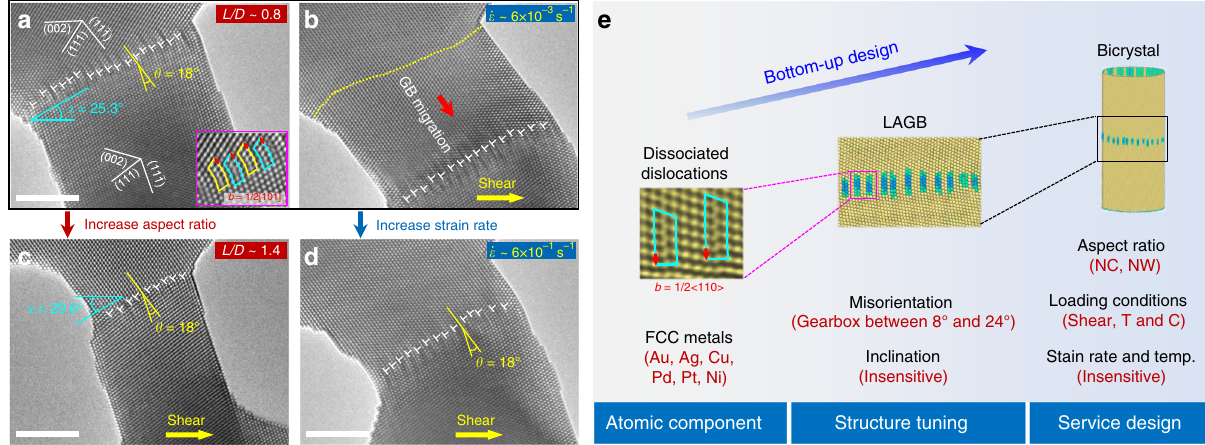
Fig. 4 Bottom-up design of plastic reversibility in Au bicrystals with dislocation-type GB. a Au bicrystal consisting of an 18° 1 (cid:1) 10 ½ (cid:2) GB, with an inclination ( α ) of 25.3°. The inset shows the staggered con fi guration of the dissociated GB dislocations ( b = 1/2[101]), as marked by the yellow and light blue concave rectangles. b GB-mediated shear deformation of the Au bicrystal under a strain rate of 6 × 10 − 3 s − 1 . c Deformation snapshot of the reversible deformation of another Au bicrystal with almost twice the aspect ratio ( L / D ) and near-identical θ and α compared with a . d GB-mediated reversible deformation of an Au bicrystal with the same 18° 1 (cid:1) 10 ½ (cid:2) GB as a under a higher strain rate of 6 × 10 − 1 s − 1 . e Schematic illustrating the bottom-up design protocol of metallic bicrystals to realize superior plastic reversibility. NC and NW represent nanocrystal and nanowire; T and C stands for uniaxial tension and compression; temp. is an abbreviate for temperature. Scale bars: 5